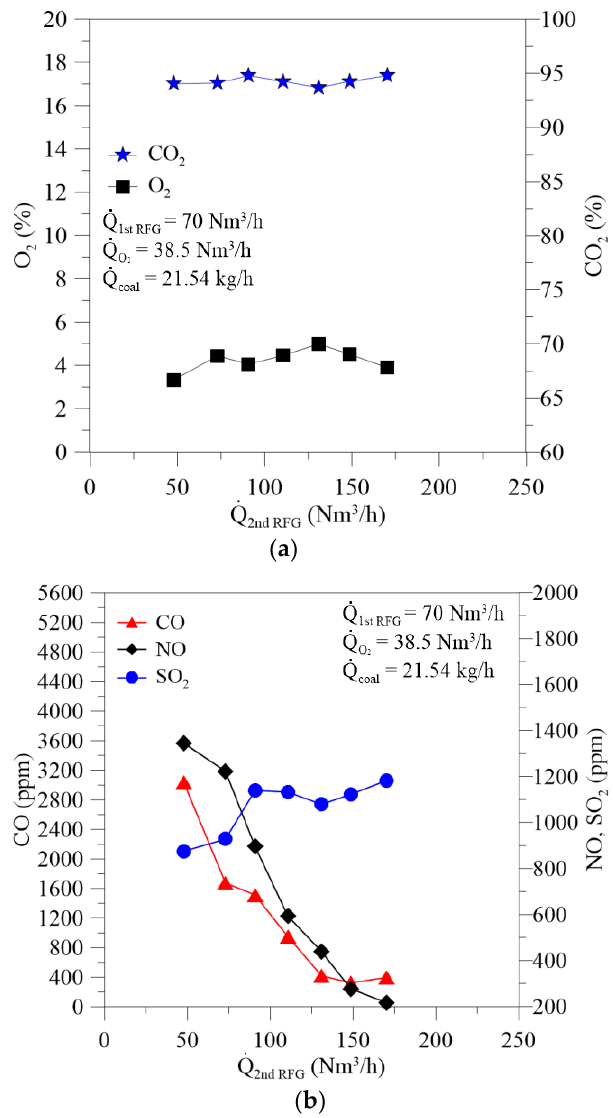
Figure 8. Variations in ( a ) CO 2 and O 2 emissions, and ( b ) CO, NO, and SO 2 emissions with 2nd RFG for Australian coal during oxy-combustion at